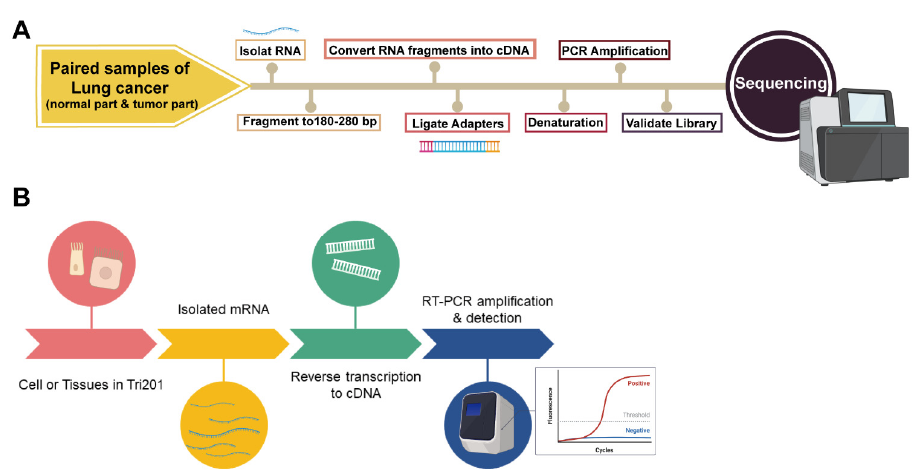
Figure A1. Graphical flow chart of experiments. Next-generation sequencing ( A ) and qRT-PCR ( B ).